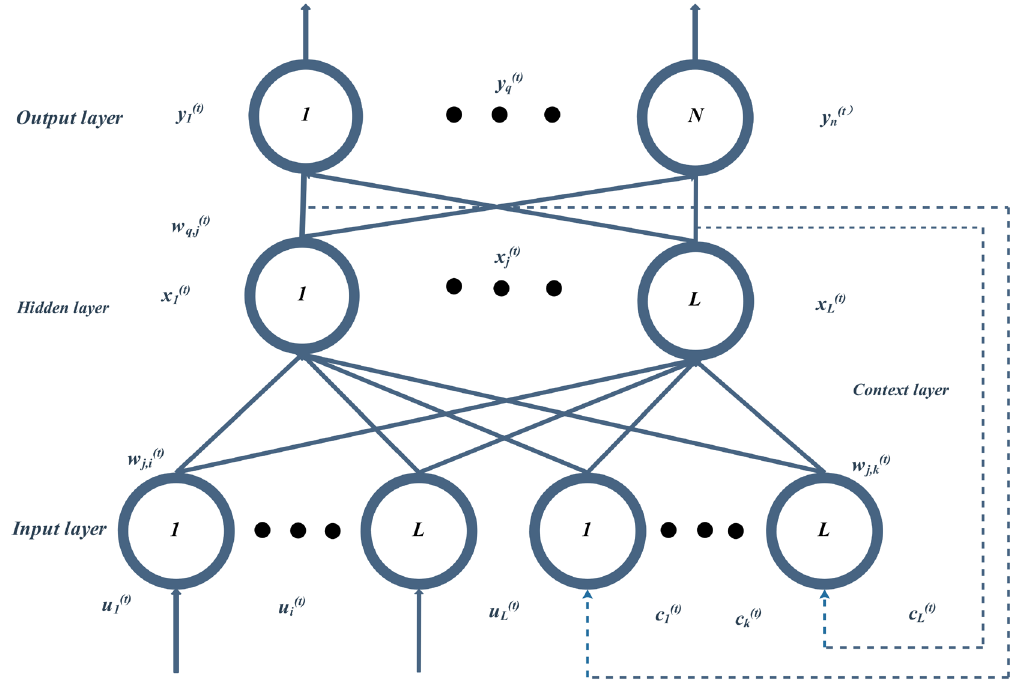
Figure 4. Structure of the Elman neural network (ENN).